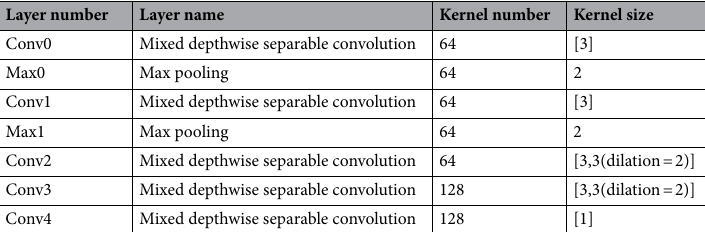
Table 1. Multi-scale feature bilinear fusion network lightweight